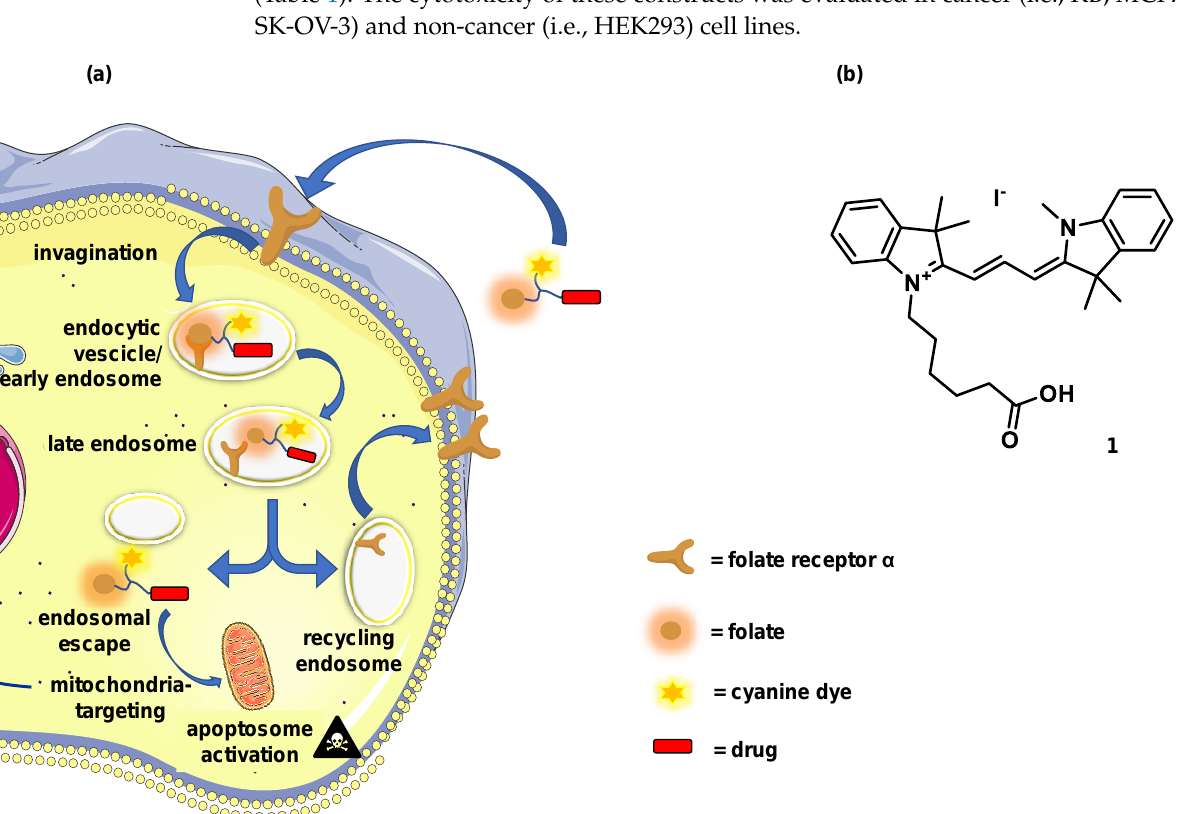
Figure 1. Folate conjugates exploit the folate receptor-mediated endosomal pathways, while the cyanine dye component delivers the construct inside mitochondria. ( a ) Folate receptor-mediated endocytosis mechanism and cyanine dye-mediated mitochondria-targeting in mammalian cells; ( b ) Chemical structure of cyanine dye 1